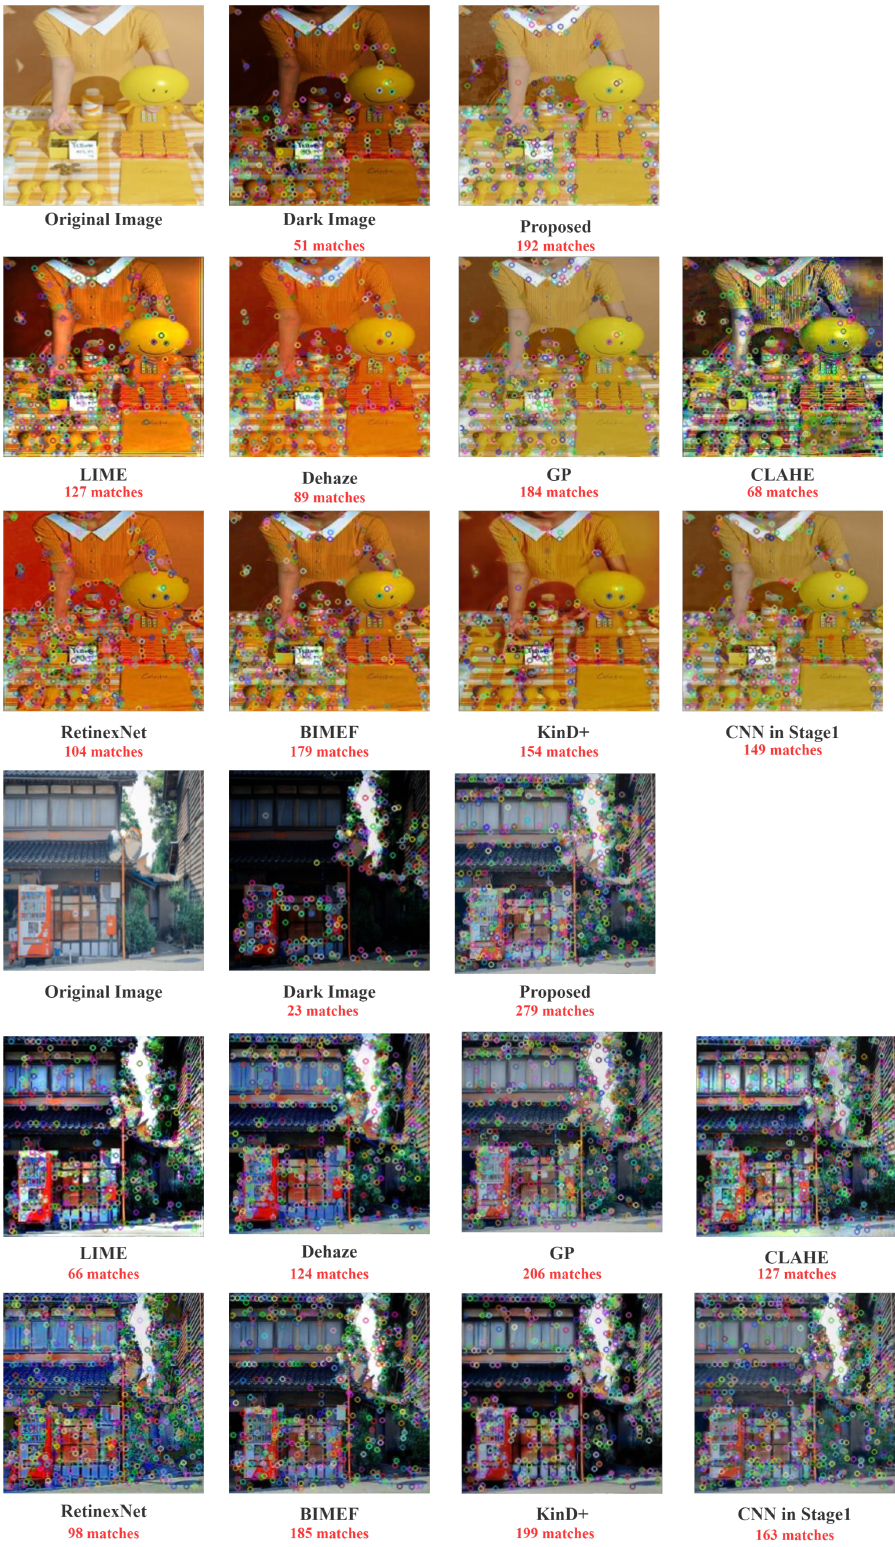
Figure 9. SIFT features matched in synthetic low-light images using different enhancement methods. The image’s feature points are represented by the colored circles in the figure, which represent the image’s color, texture, shape, and spatial relationships. Although